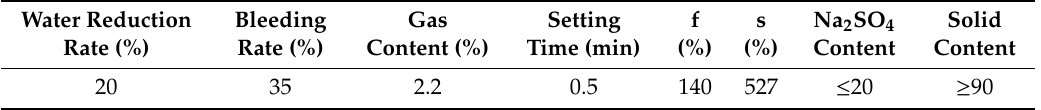
Table 4. Performance index of FDN superplasticizer.